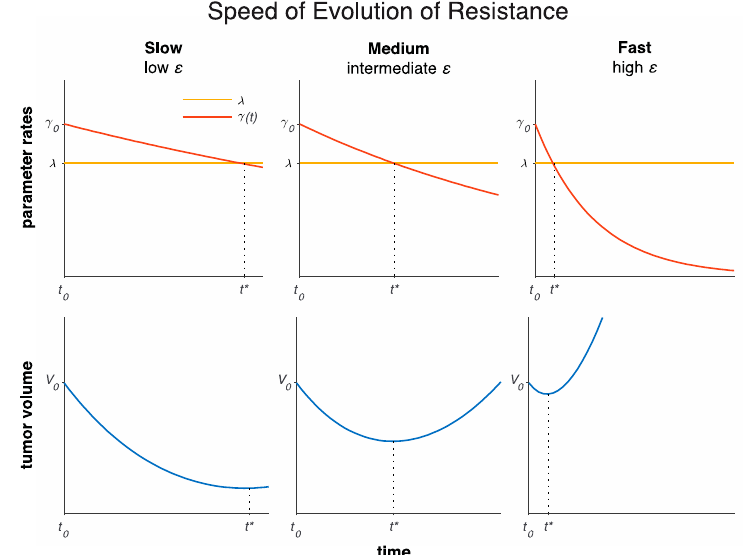
Figure 2. The model can explain a variety of tumor volume dynamics by varying the speed of evolution of resistance to therapy. A low resistance rate ε (left) yields slow evolution of resistance to therapy and long-term response with large tumor volume regression. A medium ε (middle) yields medium evolution of resistance to therapy and short-term response with medium tumor volume regression. A high ε (right) yields fast evolution of resistance to therapy and immediate progression with small tumor volume regression. Resistance to therapy and volume nadir occur at t = t ∗ , such that the net growth rate and treatment sensitivity coincide ( λ = γ ( t ∗ ) ). The legend in top left panel applies to all top panels.